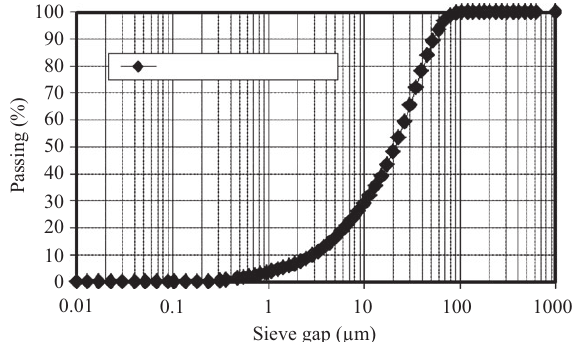
Figure 1 Particle size of the Portland cement used in the experiments.